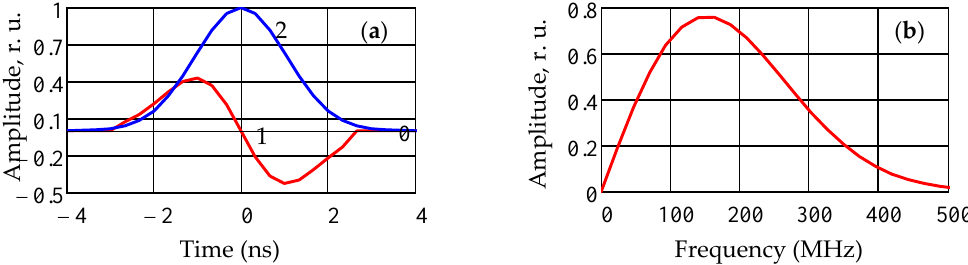
Figure 3. Waveform of the UWB signal ( a ) and the modulus of its amplitude spectrum ( b ).